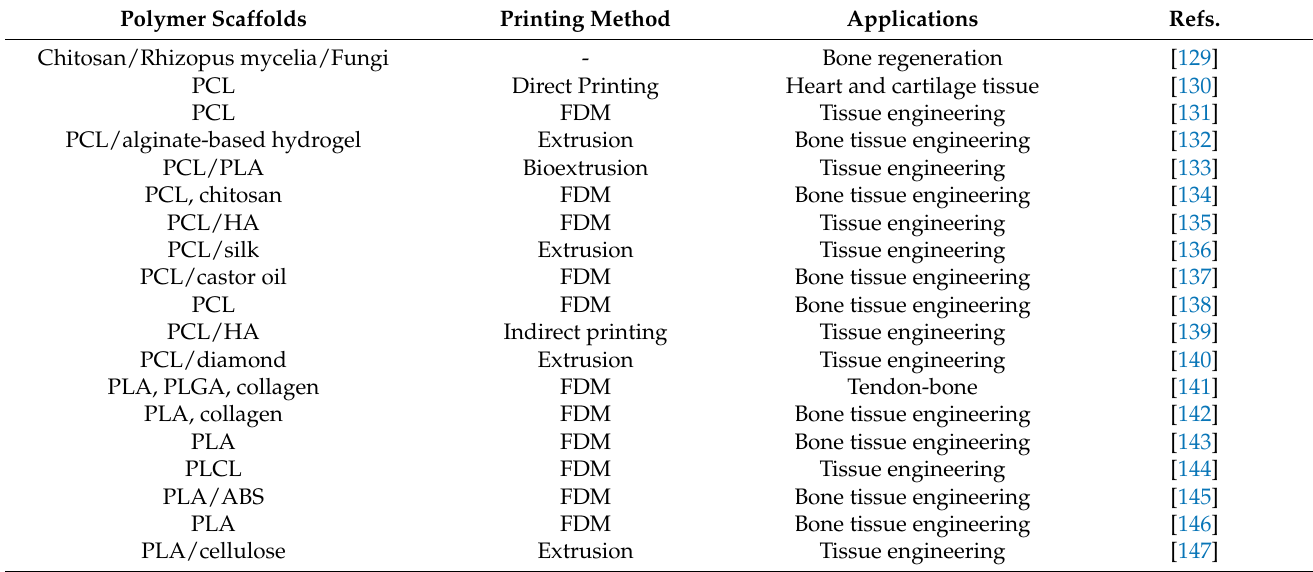
Table 3. Polymer scaffolds with applications and printing